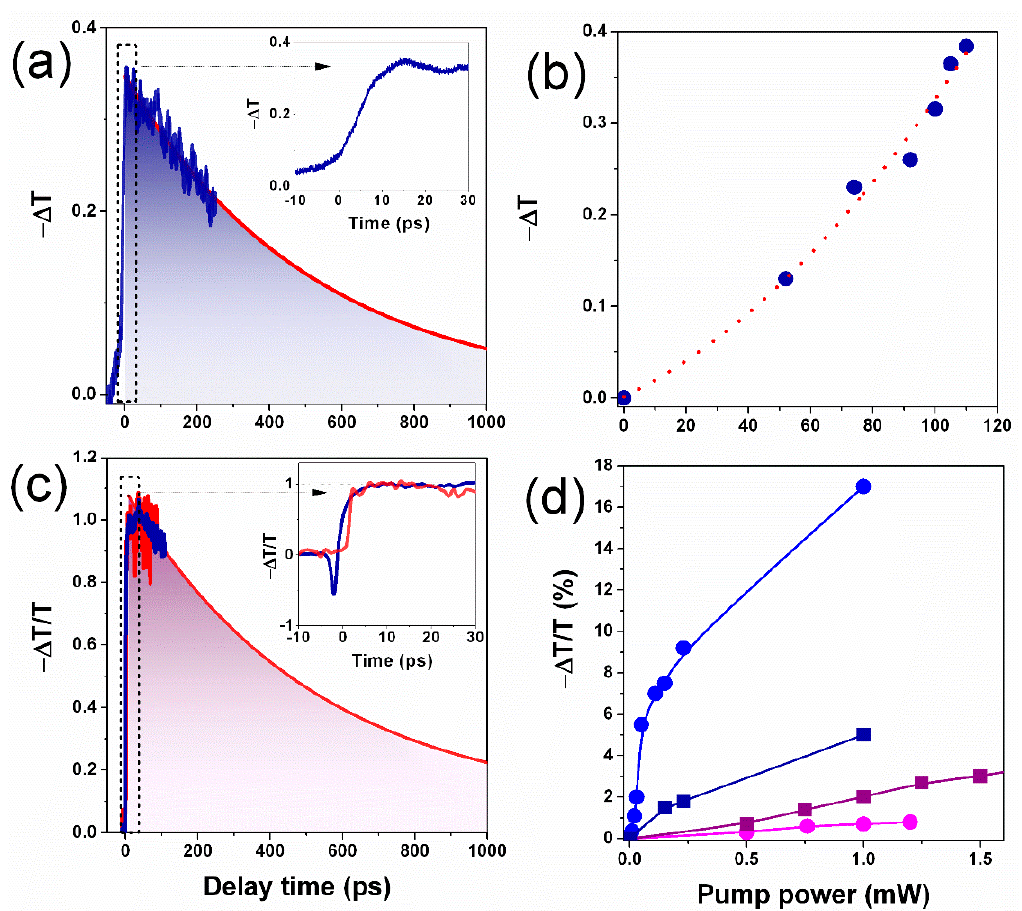
Figure 4. Temporal dynamics of the pump-induced THz/visible range transmission change in MAPbI 3 (blue) and MAPbBr 3 (red) films. ( a ) THz transmission change ( ∆ T) as a function of delay time between 800 nm pump and THz probe pulses. ( c ) Optical transmission change ( ∆ T/T) as a function of delay time between 400 nm pump and 500 nm probe 40 fs pulses. Exponential fitting with a decay constant τ = 360 ps is shown with solid red lines. ( b , d ) The transmission change amplitude as a function of the pump–pulse power. The data obtained under 400 and 800 nm excitations are shown with blue and magenta colors correspondingly.